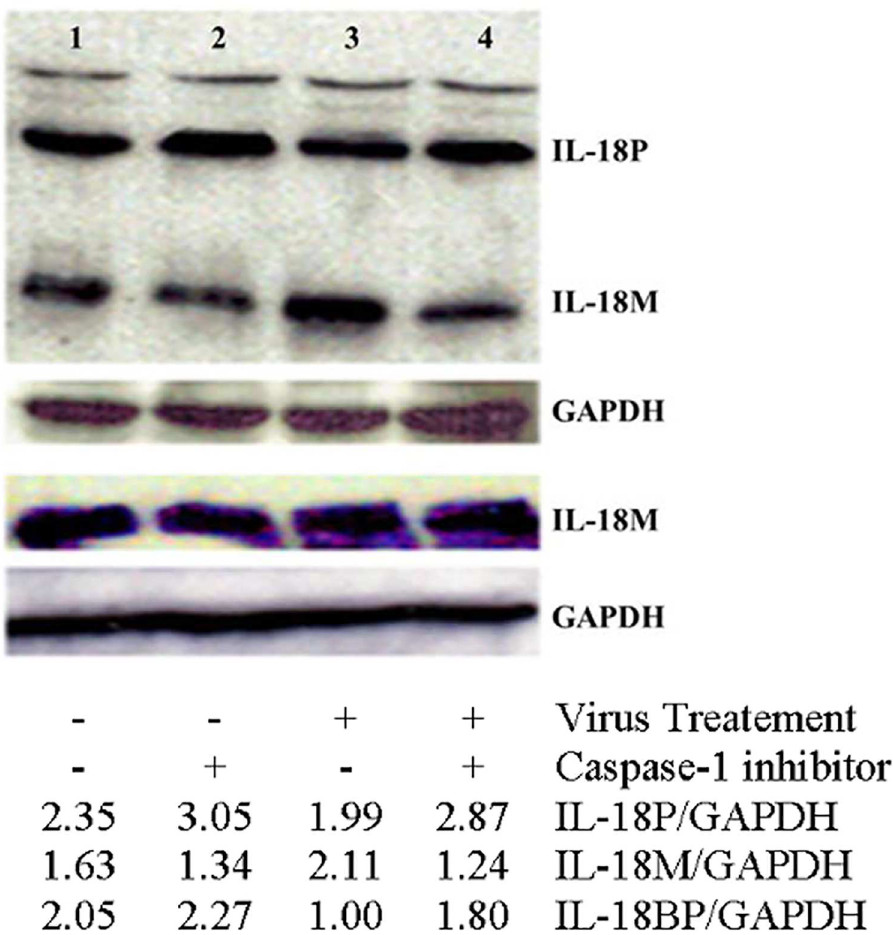
Fig 2. The effect of caspase-1 inhibitor on HIV-induced changes in IL-18 and IL-18BP in IEC. HT-29 monolayers were treated with NL4.3 at moi 1 with and without prior treatment with caspase-1 inhibitor (Z-YVAD-FMK; 50 uM). The inhibitor was added 5–10 minutes prior to the treatment with viral preparations. IL-18, IL-18BP and GAPDH were detected and quantified as described in the legend to Fig 1.